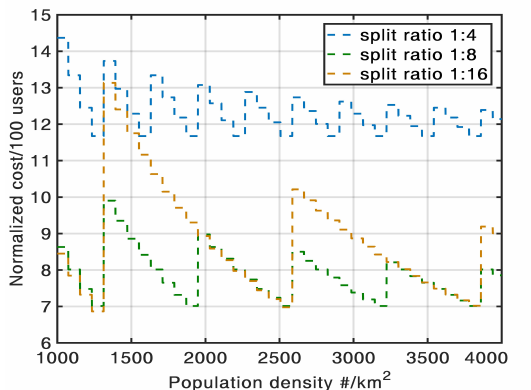
Figure 7. Variation of normalized cloudlet deployment cost/100 users against population density of the cloudlet deployment circular area with diameter = 4 km and D QoS = 1